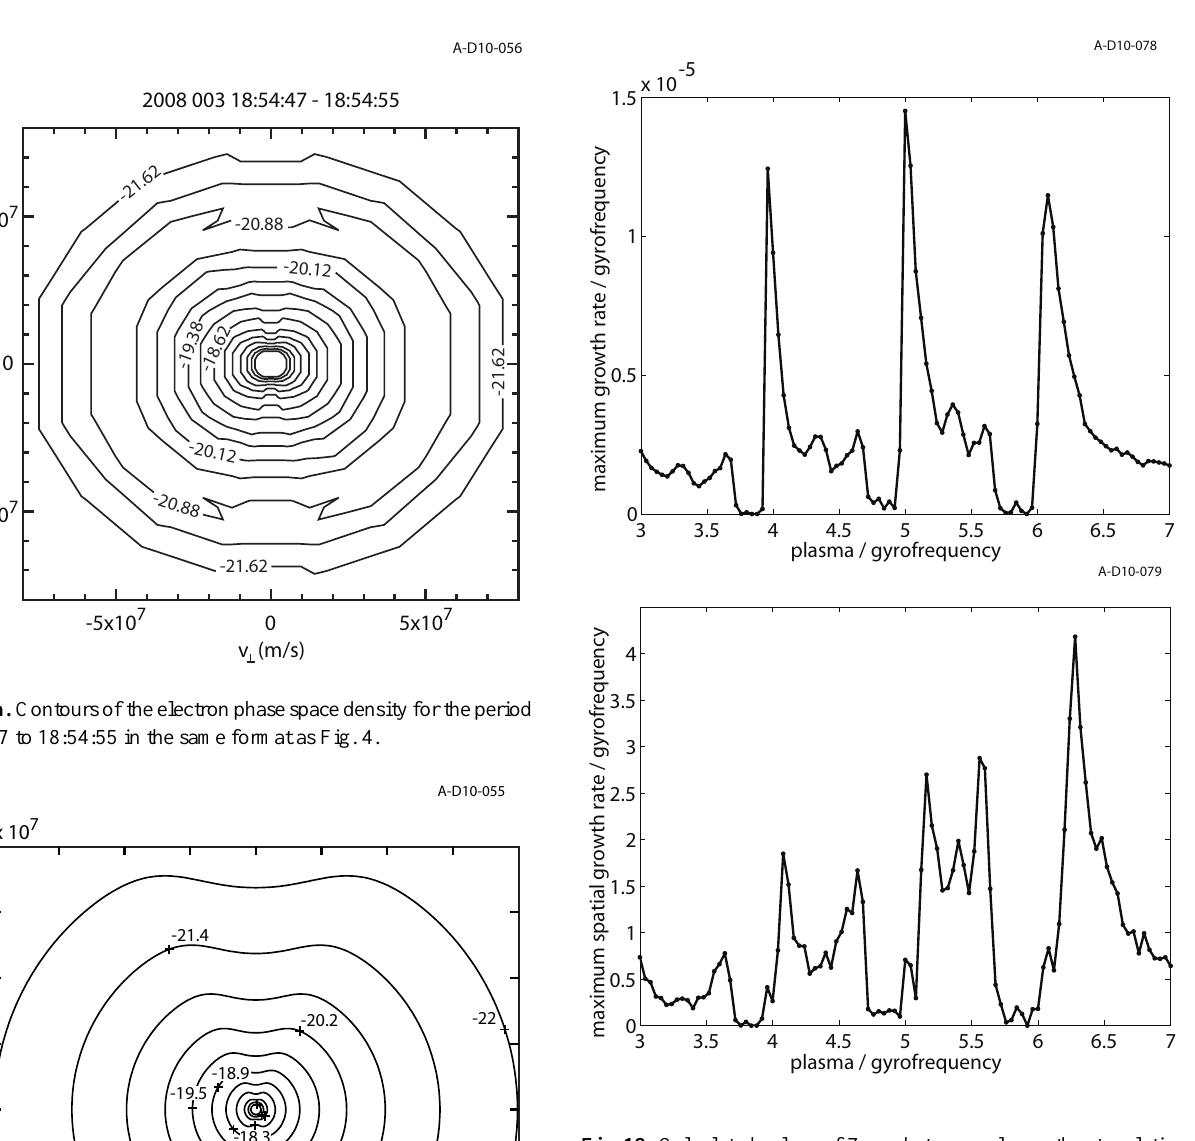
Fig. 12. Calculated values of Z-mode temporal growth rate relative to (cid:127) (a) and spatial growth rate (b) versus ω p / (cid:127) , but now for the probable source near